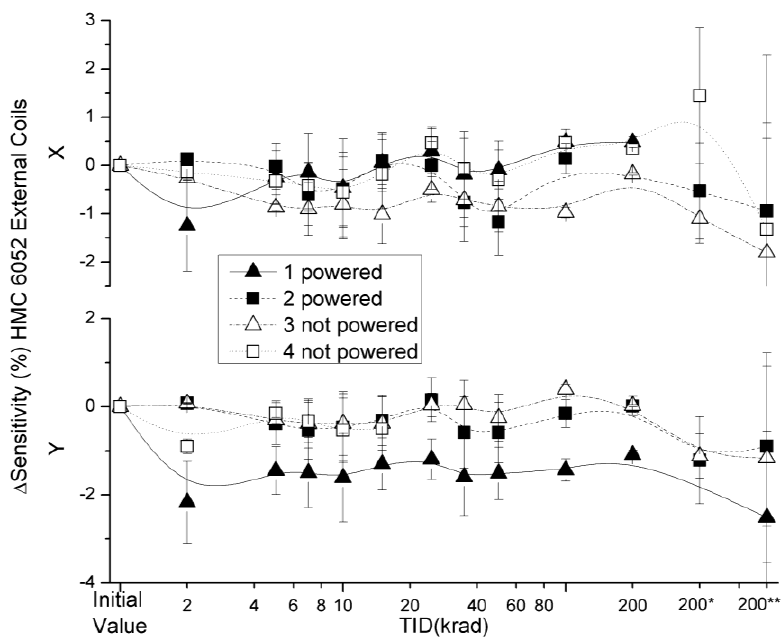
Figure 13. Sensitivity deviation measured for external coils configuration as a function of TID for powered and non-powered HMC 6052.